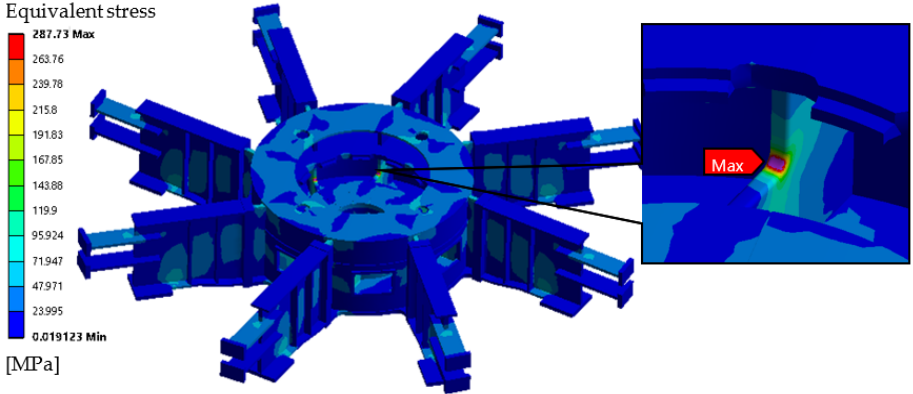
Figure 12. The equivalent stress distribution of support bracket at maximum axial force ( C ϕ = 0.0142)